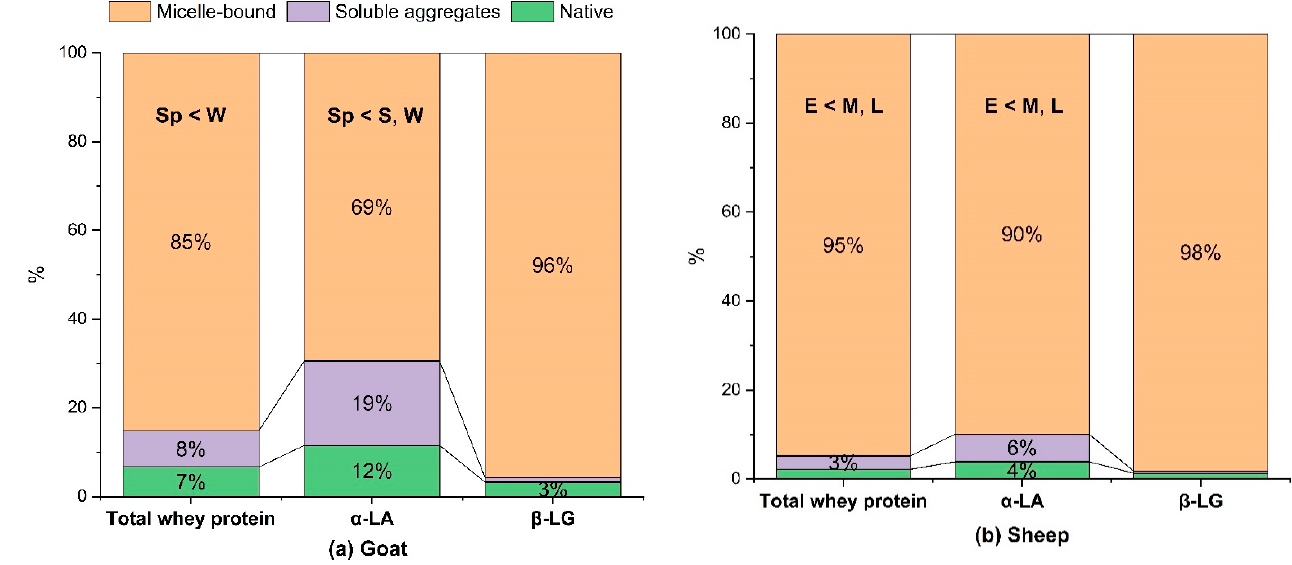
Figure 2. Distribution of whey proteins in the ( a ) goat milk and ( b ) sheep milk heated at 95 °C for 5 min (fractions below 3% are not labeled); significant seasonal differences in the micelle-bound fraction are indicated ( p < 0.05); Sp, spring; S, summer; W, winter; E, early season; M, mid-season; L, late season.